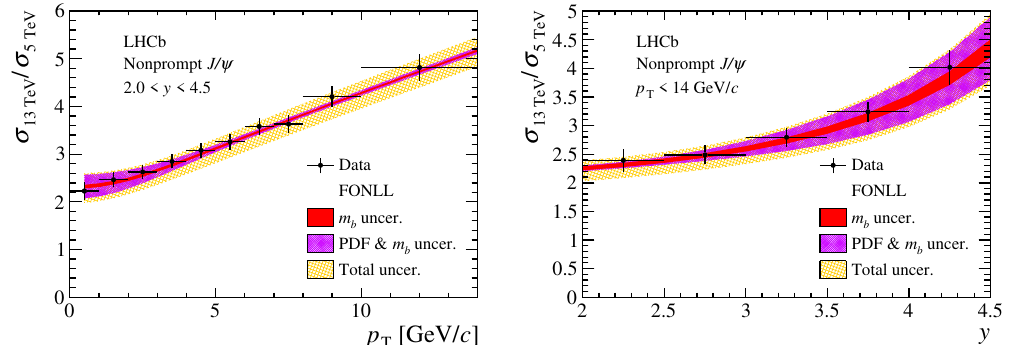
Figure 9 . Ratios of differential cross-sections between 13 TeV and 5 TeV measurements as a function of (left) p T and (right) y for nonprompt J/ψ mesons compared with FONLL calculations [58, 59]. The orange band shows the total FONLL calculation uncertainty; the violet band shows the uncertainties on PDFs and that due to b -quark mass added in quadrature; the red band shows only the uncertainty due to b -quark